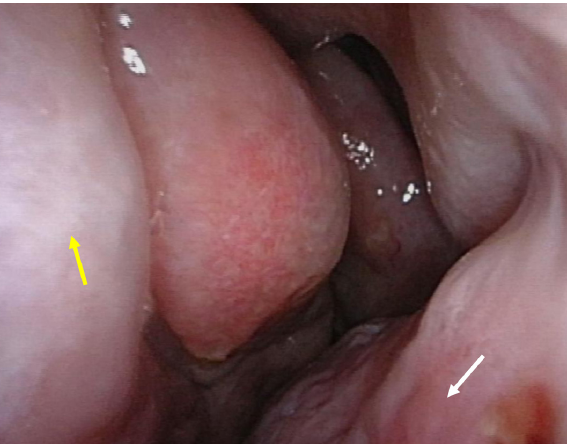
Figure 2. Preoperative nasal endoscopic examination. Polypoidal changes in the nasal septum (yellow arrow) and hypertrophy of inferior concha (white arrow) were noted. There is a lack of middle turbinate and axilla of middle